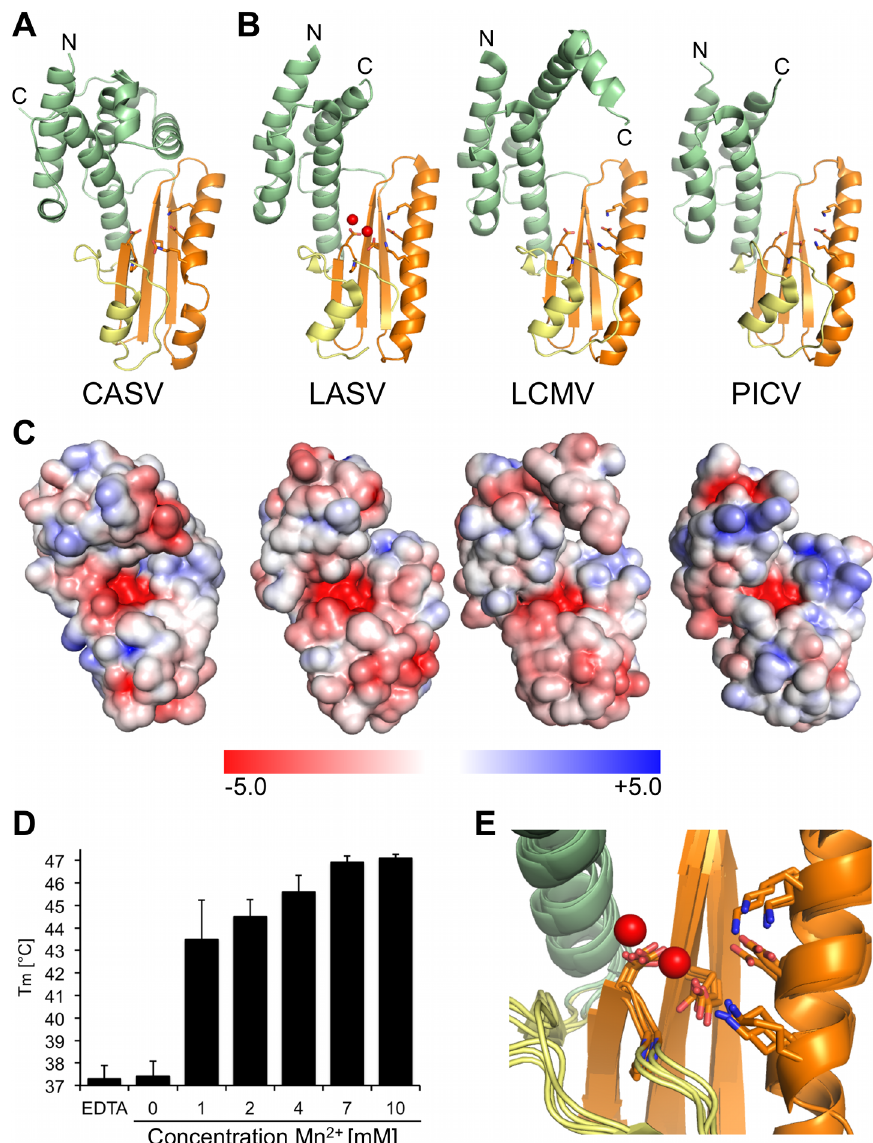
Fig 6. Structure and thermal stabilization of CASV endonuclease. A) Ribbondiagram of the CASV endonuclease crystal structure. N- and C-termini are labelledand active site residues are shown as sticks. The conserved β -sheet and the long α -helixare colored in orange, a conservedhelix-bundledomainin green and the remainingpart with loops and α -helicesin yellow. B) Endonuclease structures of LASV (PDB ID 5J1P), LCMV (PDB ID 3JSB) and PICV (PDB ID 4I1T) are shown as ribbondiagrams and coloredaccording to CASV endonuclease in A). Manganeseions of LASV structure 5J1P are shown as red spheres, active site residues are shown as sticks, and N- and C-terminiare marked. C) Electrostatic surface potential of the endonuclease structures shown in A) and B). The surface potential is shown from -5 KT/e in red to +5 KT/e in blue and was calculatedusing PDB2PQR and the APBS-tool of PyMOL. D) Thermal stability of CASV endonuclease depending on Mn 2+ concentration. Melting temperatures are presented as mean and standard deviations of three independent measurements. Stability of the protein was tested in presenceof different concentrations of Mn 2+ and in presence of 10 mM EDTA. E) Close-upof the superimposed endonuclease active sites of the structures shown in A) and B). Conservedactive site residues are shown as sticks, and manganese ions of LASV structure 5J1P are shown as red spheres.